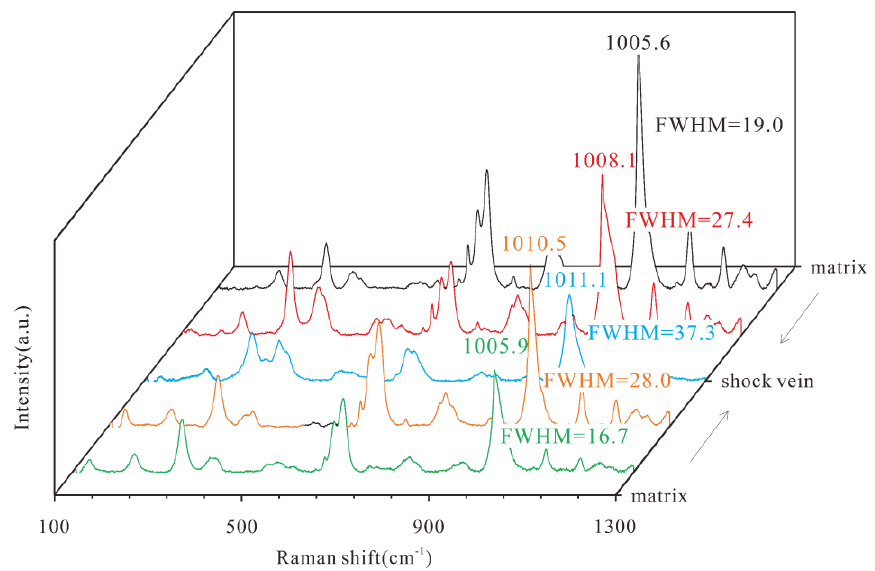
Figure 7. The Raman spectrum of olivine at different position in GRV 090511.